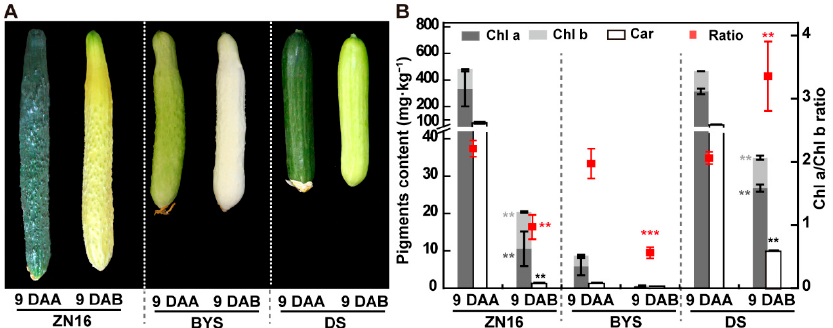
Figure 2. Changes in appearance quality of darkening cucumber fruits. ( A ) The color change in fruit exocarp of different cucumber genotypes at 9 DAA/9 DAB. Bar = 1 cm. ( B ) Pigments (chlorophyll and carotenoid) content based on per unit fresh weight in fruit exocarp of different cucumber fruits at 9 DAA/9 DAB. The red points in ( B ) represent the Chl a/Chl b ratio indicated by the Y ‐ axis on the right. Error bars represent the standard deviation, n = 3. Significant differences were assessed by Tukey’s test (** P < 0.01 , ***P < 0.001). Car, carotenoid; Chl, chlorophyll; DAA, days after anthesis; DAB, days after bagging.